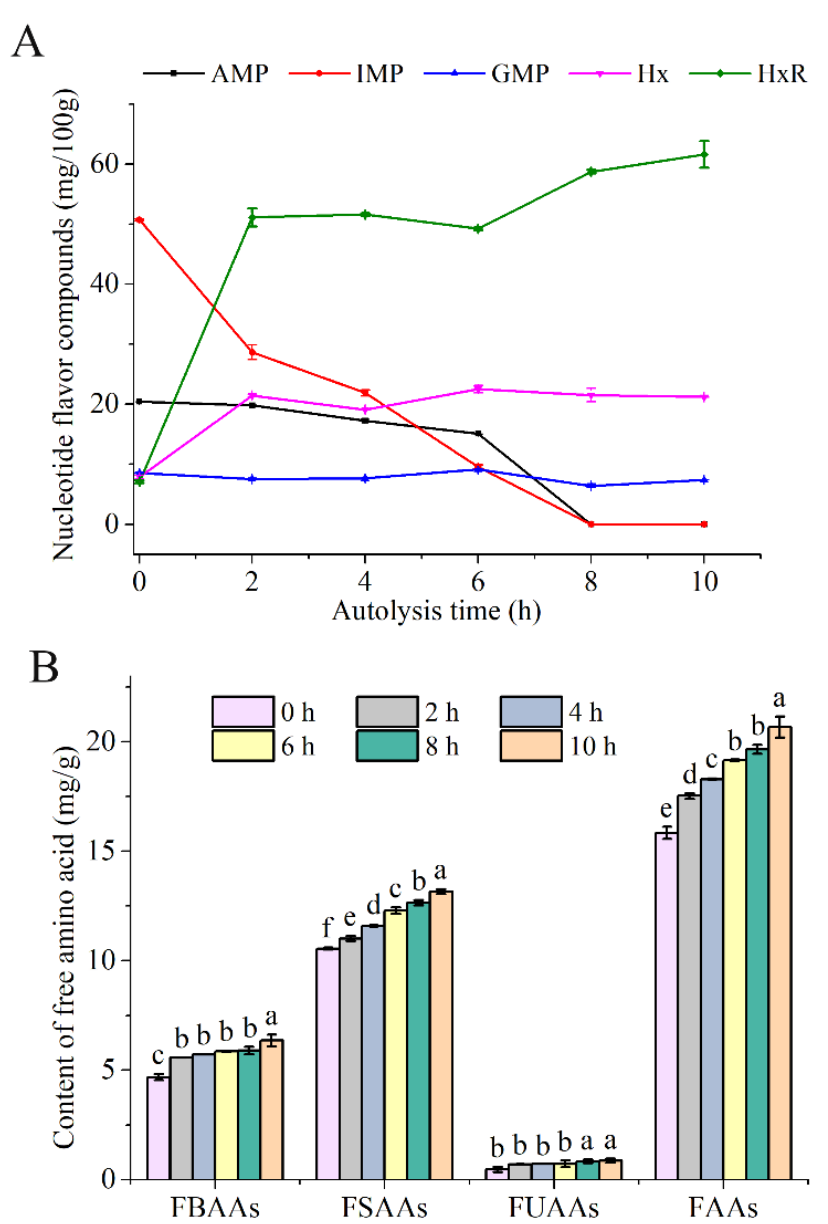
Figure 2. The change of different ( A ) FAAs and ( B ) nucleotide flavor compounds in SH during autolysis. The data marked by different letters means significantly different ( p < 0.05) in each group. FBAAs, total free bitter amino acids; FSAAs, total sweet amino acids; FUAAs, total free umami acid; FAAs, total free amino acids. Umami amino acids including aspartic acid and glutamic acid. Sweet amino acids including threonine, serine, proline, glycine, methionine, alanine. Bitter amino acids including isoleucine, valine, leucine, tyrosine, methionine, phenylalanine, lysine, histidine,